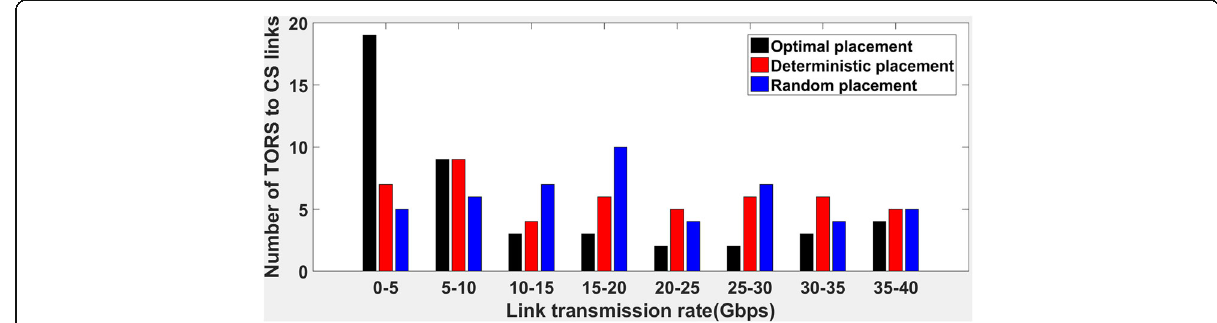
Fig. 10 Histogram of the number of TORS to CS links for optimal, deterministic and random placement of the jobs as a function of the link transmission rate with variable VM traffic rate